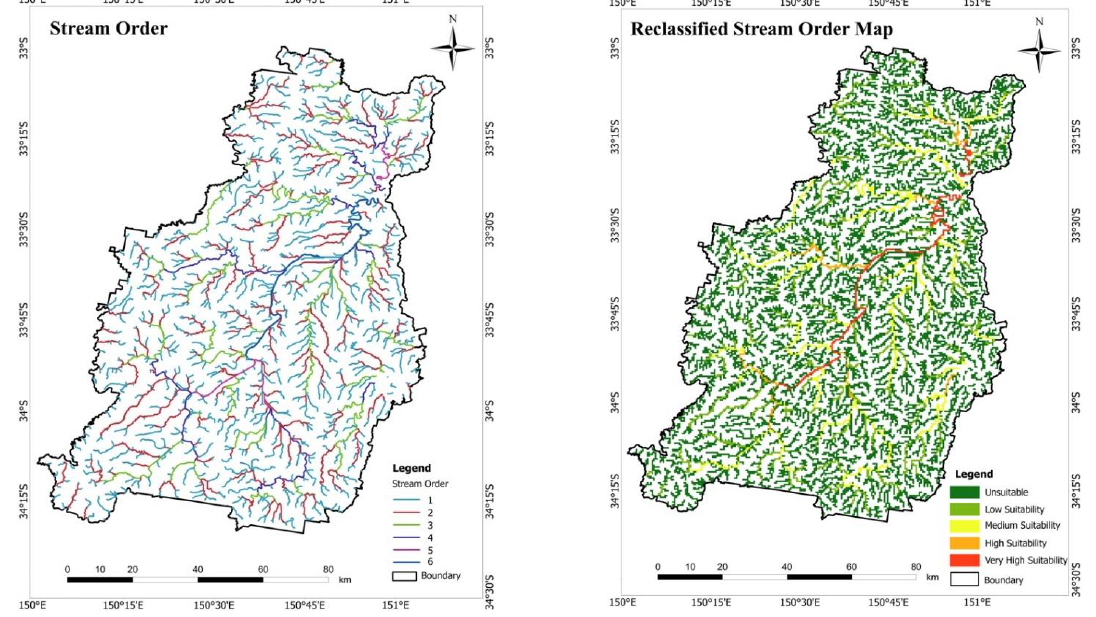
Figure 9. Study area’s stream order and reclassified map stream order ( left ); reclassified stream order ( right ).